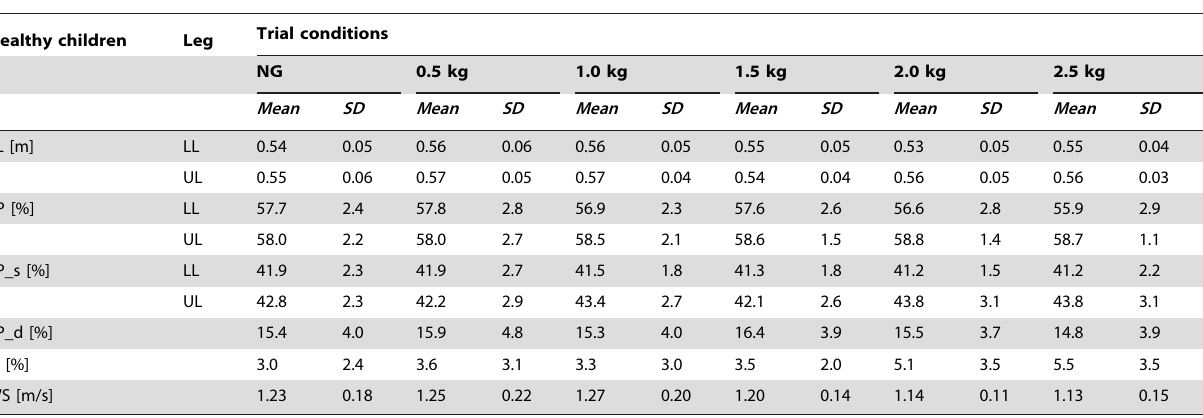
Table 1. Spatiotemporal parameters of loaded and unloaded leg for healthy children.